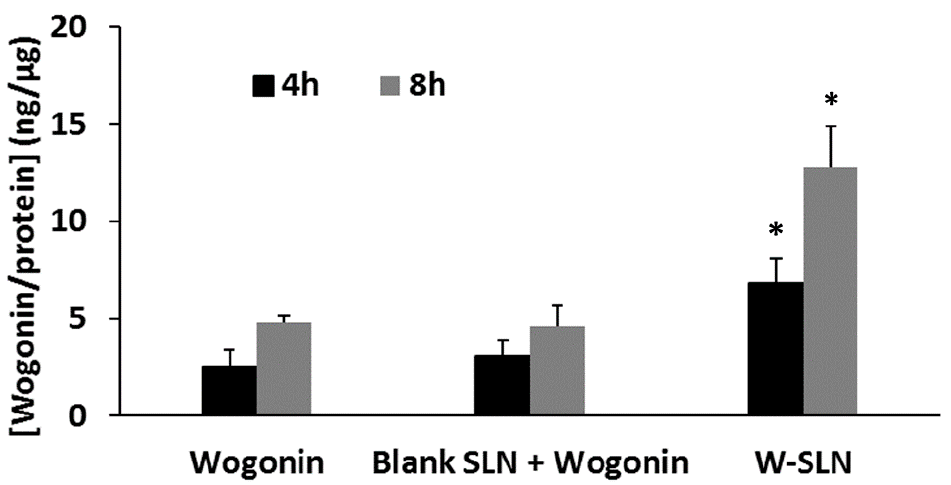
Figure 6. Cellular uptake of wogonin (10 nM) from free wogonin solution, blank SLN with free wogonin, and W-SLN at different time points (4 and 8 h) in MCF-7 cells ( n = 3, mean ± SD). * p > 0.05 shows a significant difference from wogonin.